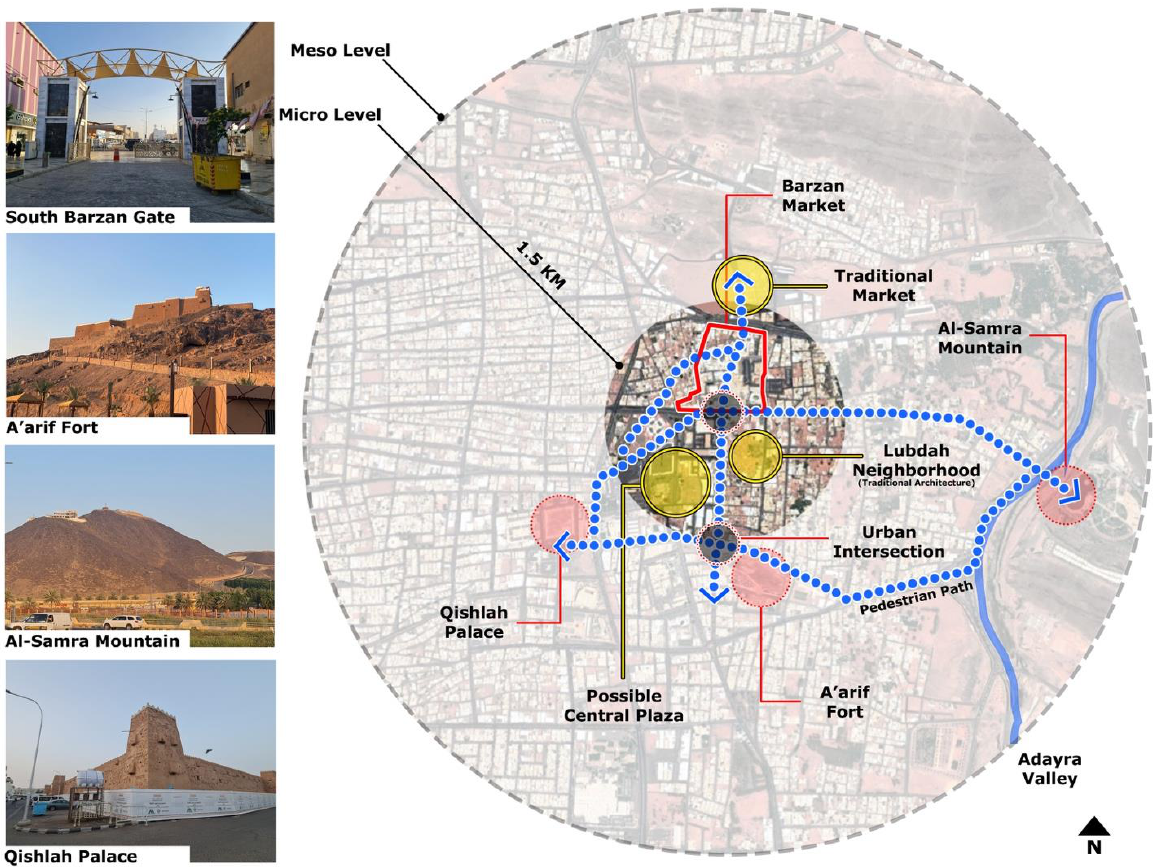
Figure 17. Meso level of the city center showing the potentiality of linking other significant historical landmarks with Barzan Market. Source: Authors.